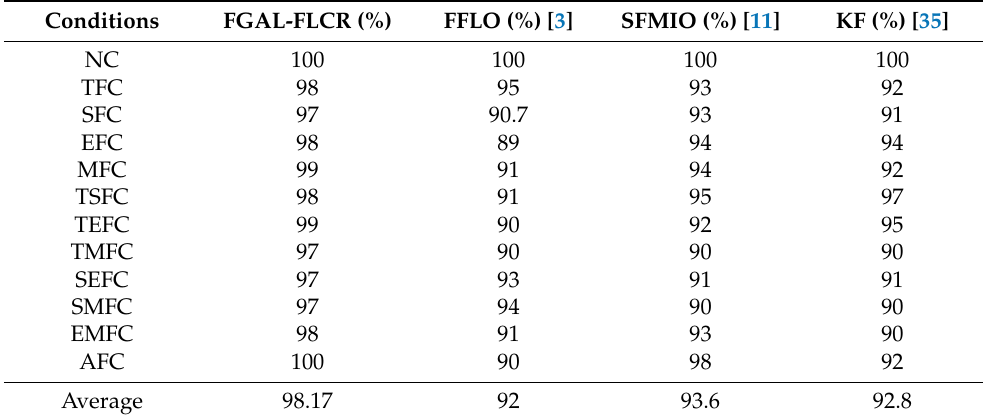
Table 2. Average accuracies of sensor fault diagnosis according to the proposed FGAL-FLCR, FFLO, SFMIO, and KF